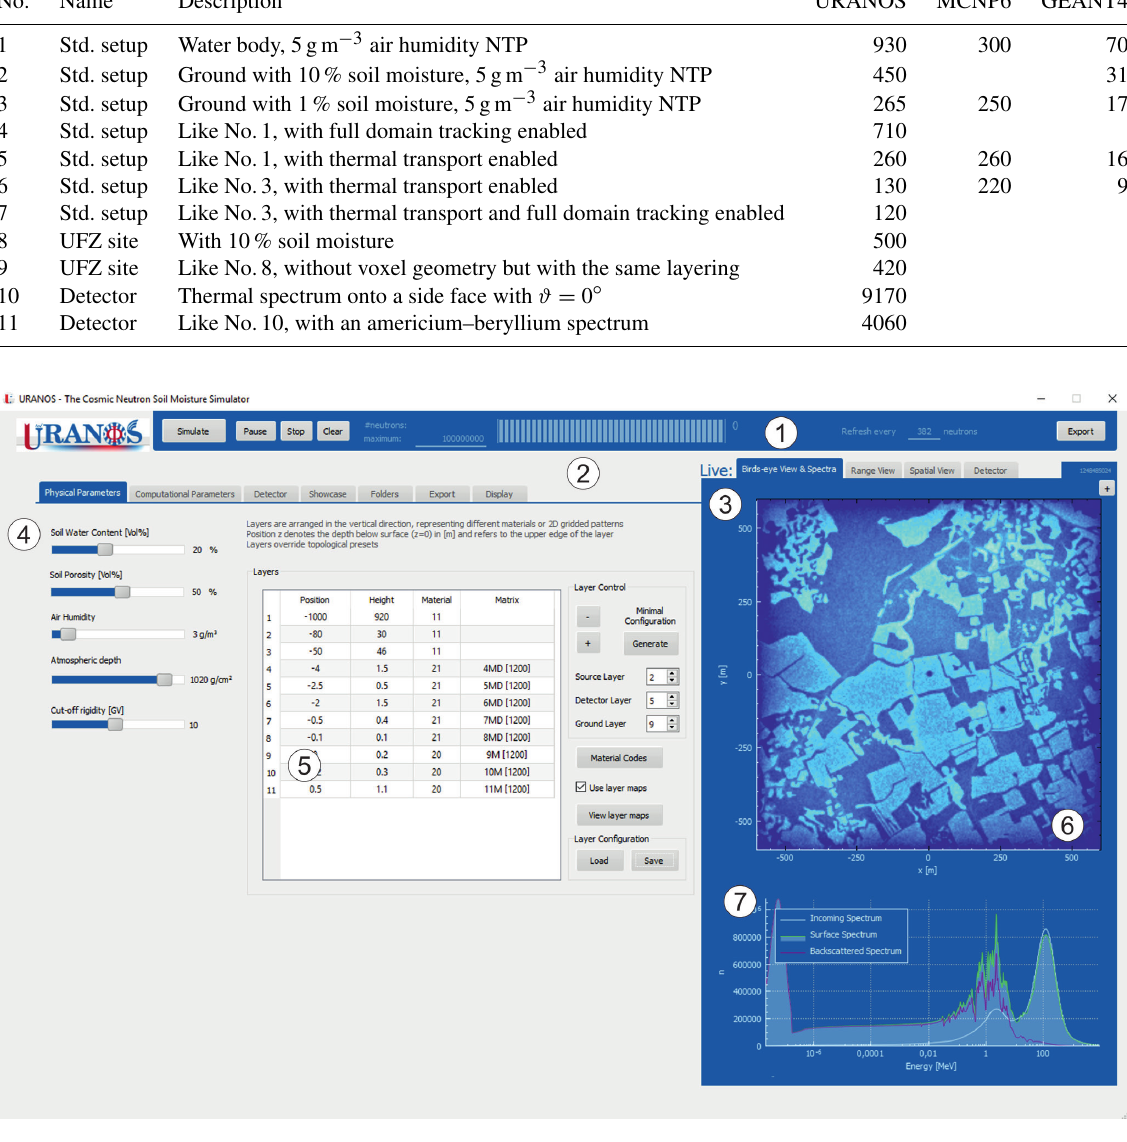
Figure 16. URANOS main user interface with (1) main simulation control bar, (2) configuration tabs, (3) Live View tabs, (4) global envi- ronmental settings, (5) geometry stack with two layers defined by voxels, (6) Bird’s eye View of the neutron flux within the domain in the detector layer and (7) cosmic-ray neutron spectrum above the